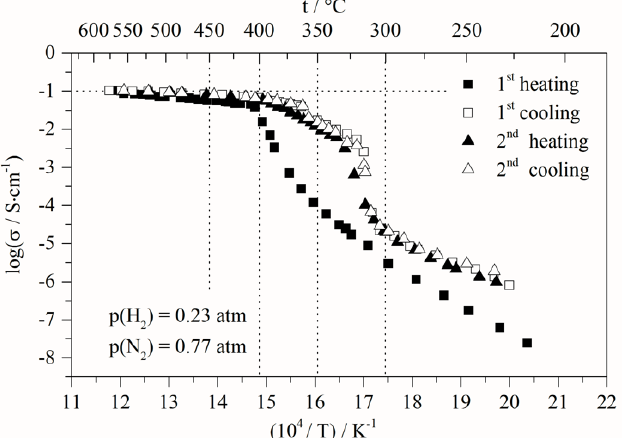
Figure 2. Arrhenius diagram of the conductivity during two heating/cooling cycles for SDC—LiNaK composite electrolyte performed under 23%—H 2 —in—N 2 dry